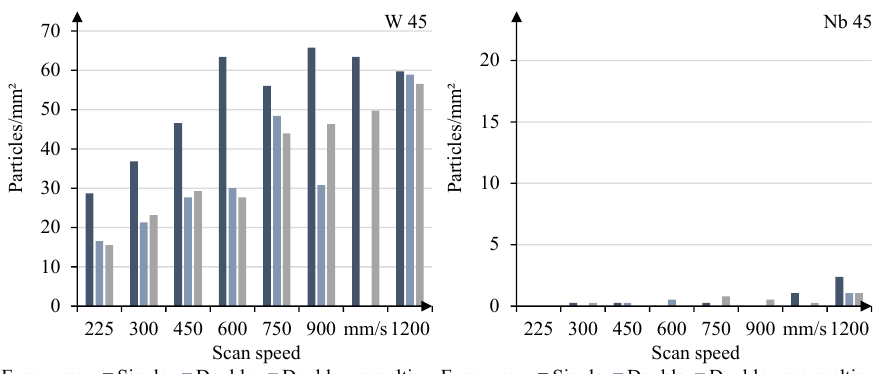
Figure 9. Results of experiment series 3 (see Table 2): single exposure, simple double exposure, double exposure with low VED pre-melting, laser power scales linearly with the scan speed (VED 55 J/mm 3 ), sample at 1050 mm/s not available.